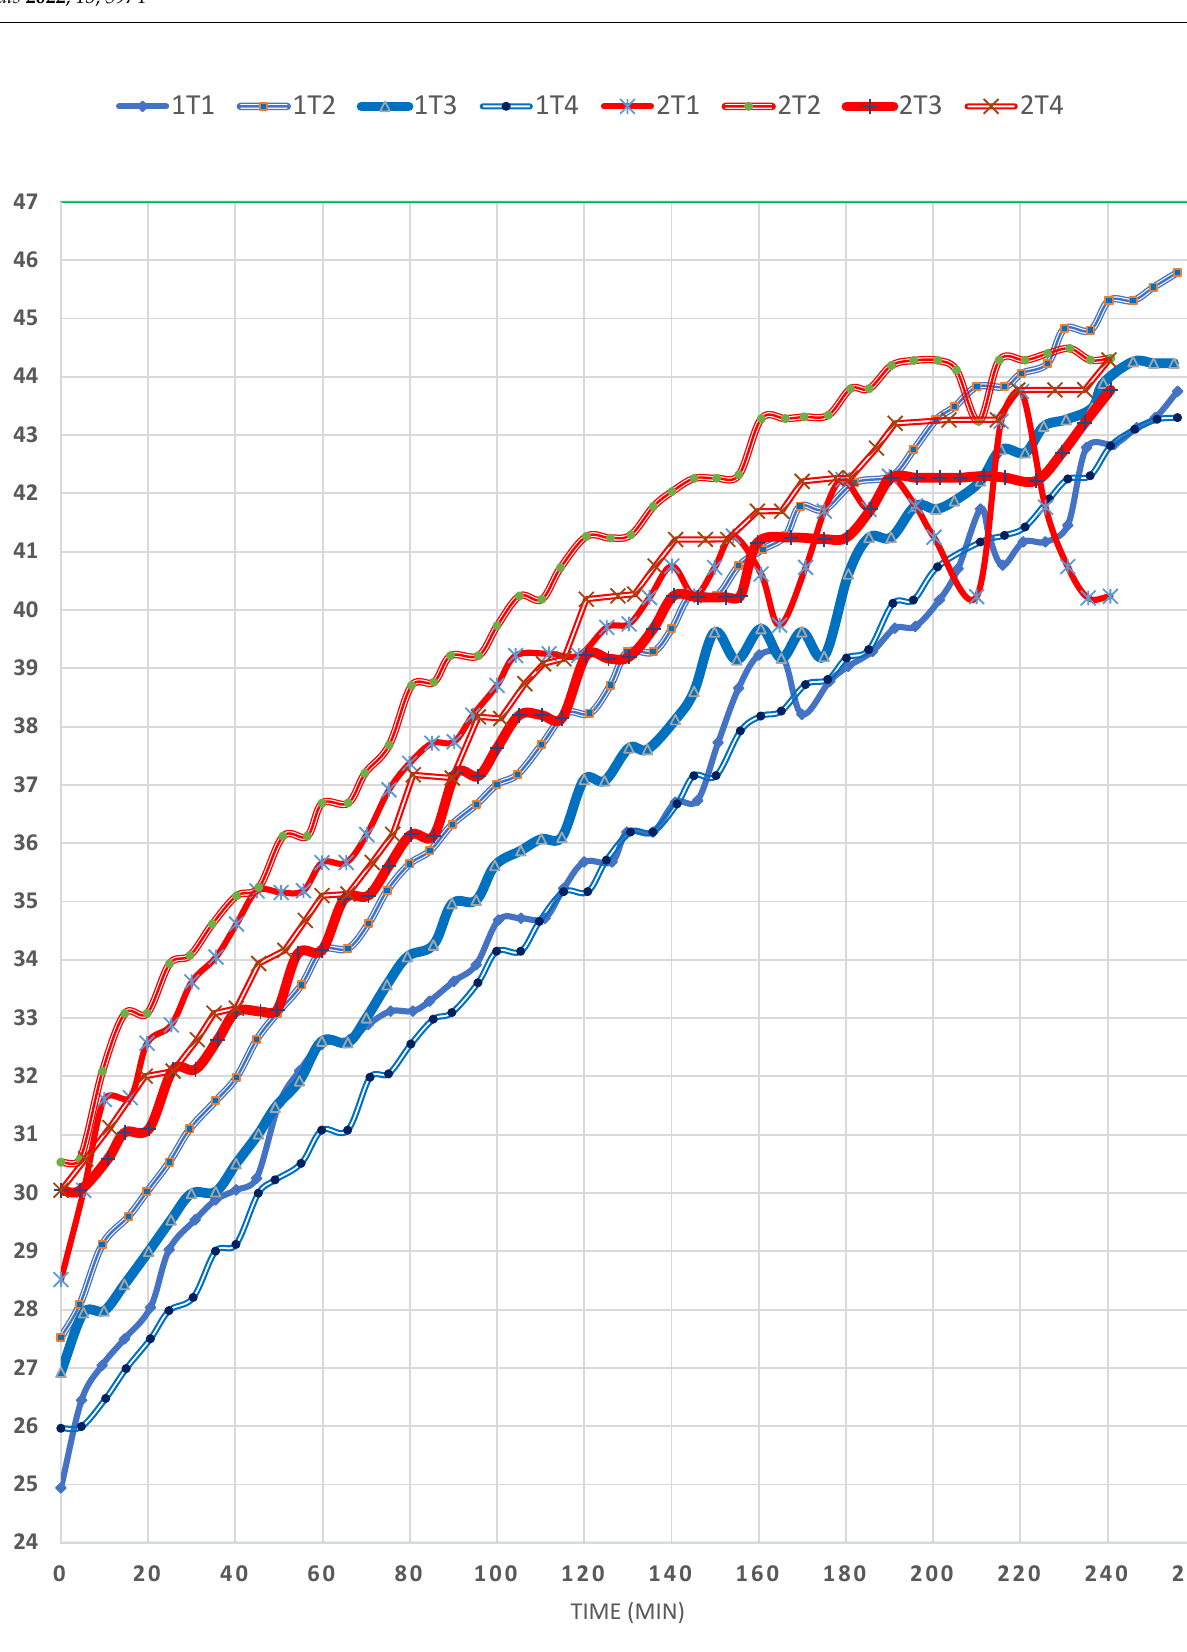
Figure 2. Effect of the mirror slope on the temperature profiles in the SP (EXPs (1) and (2)).